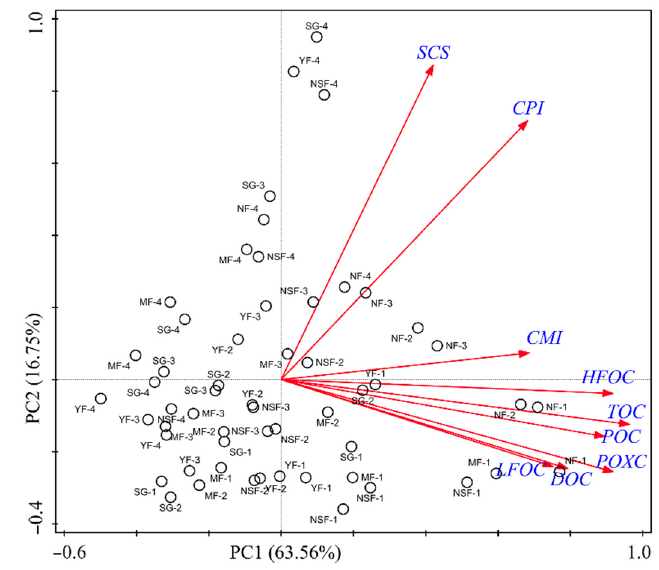
Figure 9. Principal component analysis for all vegetation types involving the carbon fractions and carbon indices. TOC, total organic carbon; DOC, dissolved organic carbon; LFOC, light fraction organic carbon; HFOC, heavy fraction organic carbon; POXC, permanganate oxidizable carbon; POC, particulate organic carbon; CPI, carbon pool index; CMI, carbon management index; SCS, soil carbon sequestration capacity; NF, natural forest; SG, shrub-grass land; PF, coniferous Pinus forest; MF: coniferous and broad-leaved mixed forest; NSF, natural secondary forest; 1–4 indicates soil 0–10, 10–30, 30–60, and 60–90 cm depths.